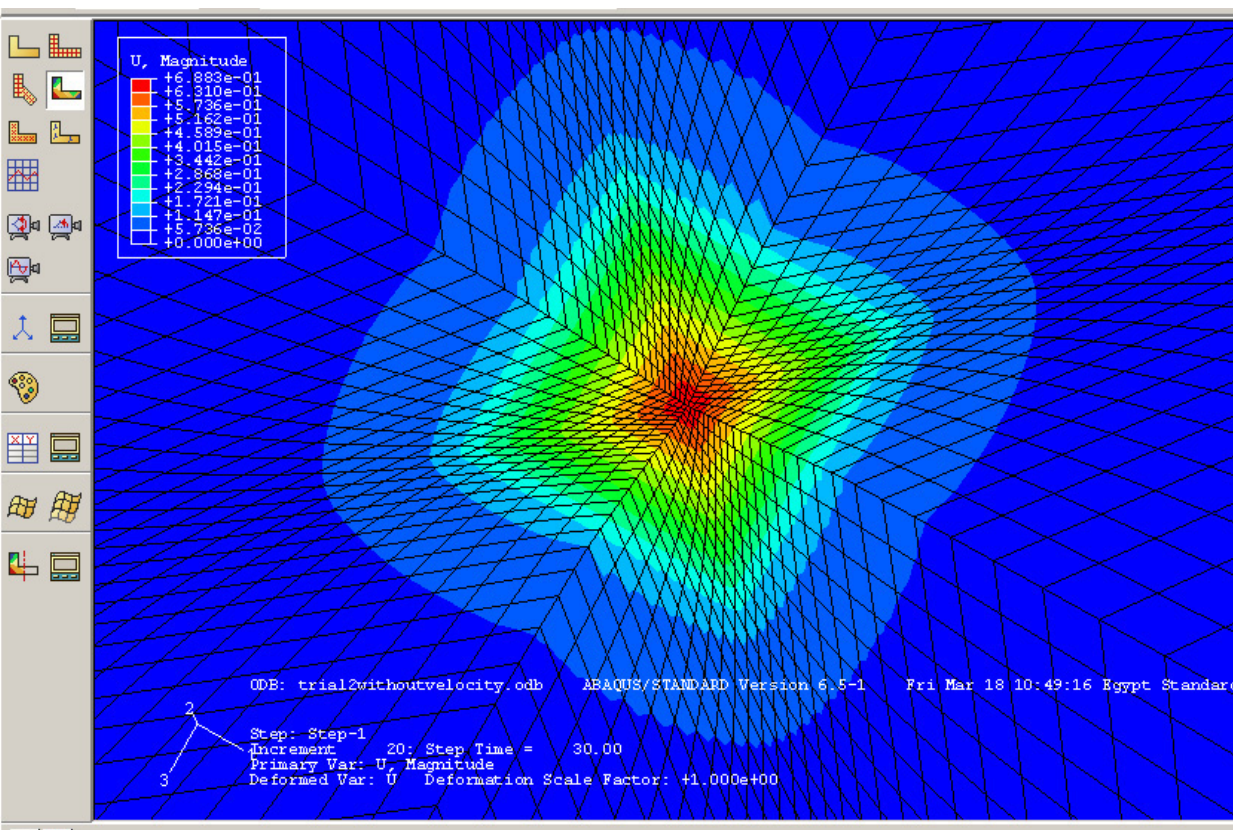
Fig. 8. (Color online) Indentation shape of the Vickers hardness.